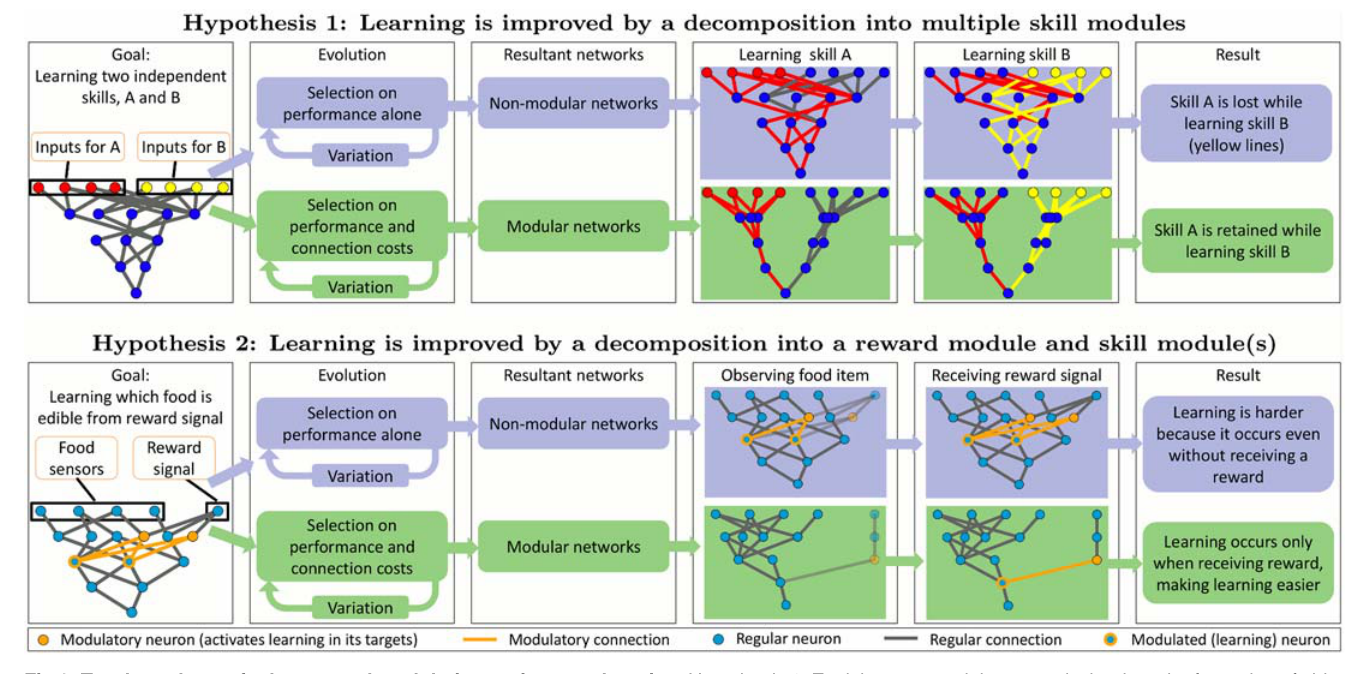
Fig 1. Two hypotheses for how neural modularity can improve learning. Hypothesis 1: Evolving non-modular networks leads to the forgetting of old skills as new skills are learned. Evolving networks with a pressure to minimize connection costs leads to modular solutions that can retain old skills as new skills are learned. Hypothesis 2: Evolving modular networks makes reward-based learning easier, because it allows a clear separation of reward signals and learned skills. We present evidence for both hypotheses in this paper.